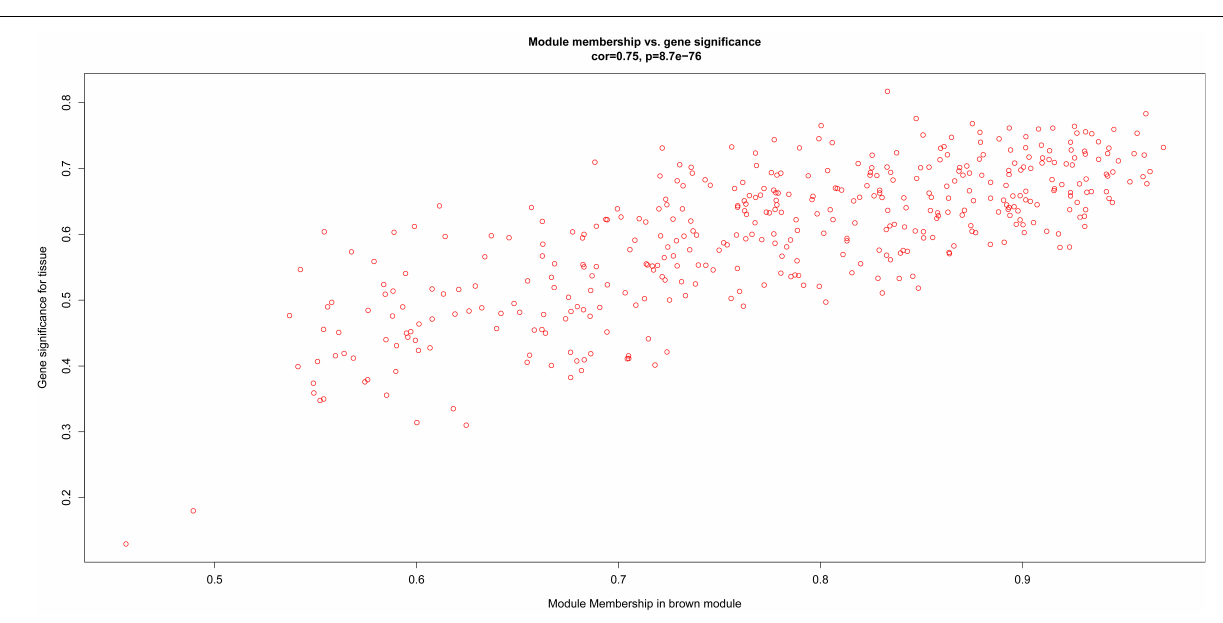
FIGURE 6 | Scatter diagram for module membership vs. gene significance of tissue (LT or MT) in brown module.